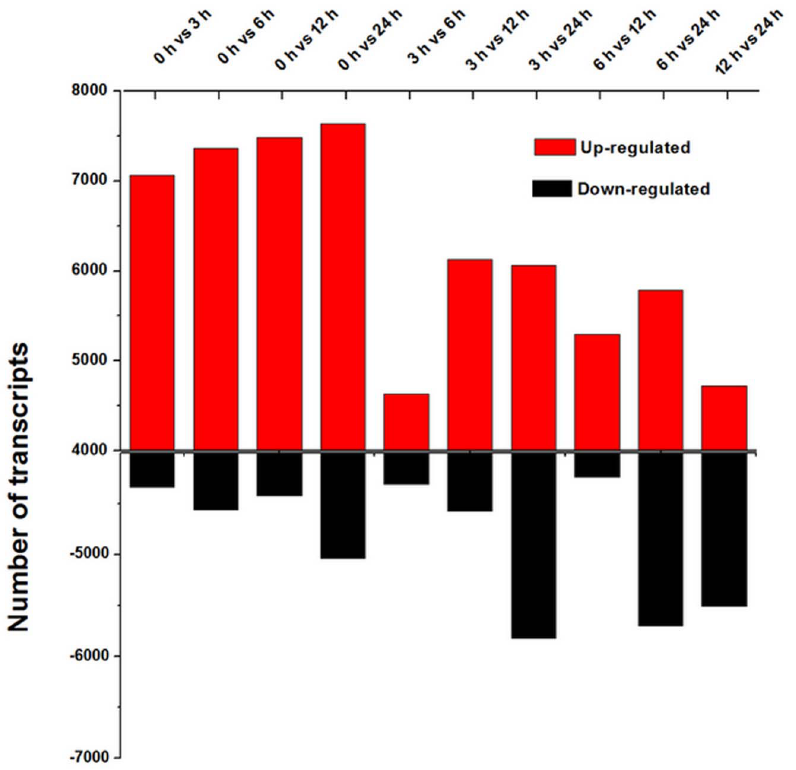
Figure 5. Transcripts that exhibited differential expression pattern. In total, 20,5325 contigs were used for the differential expression analysis, and the differential transcripts were identified by edgeR using the following parameters: FDR # 0.05 and log 2 fold-change $ 1.